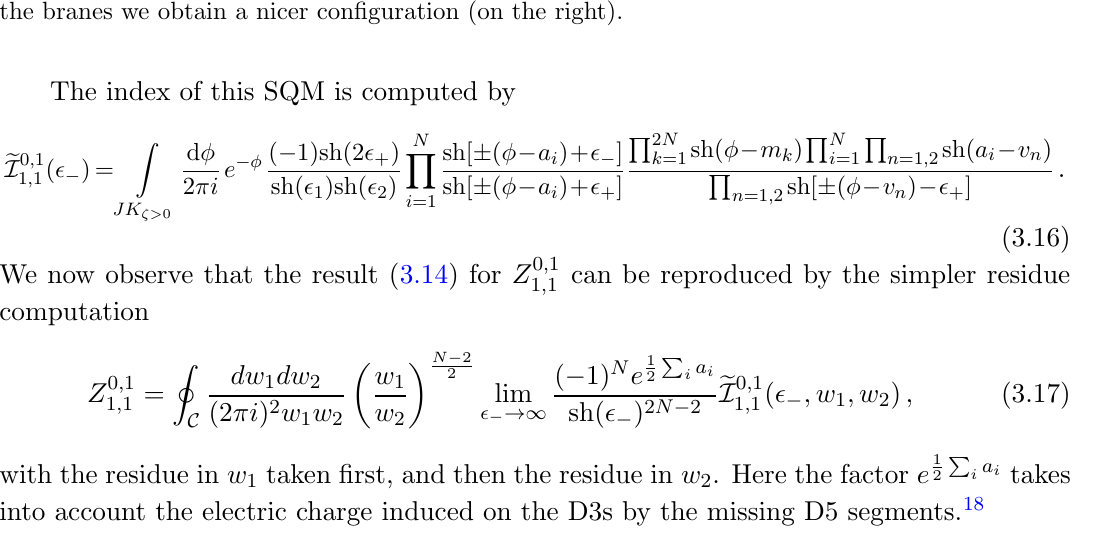
Figure 15 . Initial brane setup and completion for the L 2 loop in SU(2) N f = 4 theory. Moving the branes we obtain a nicer con(cid:12)guration (on the